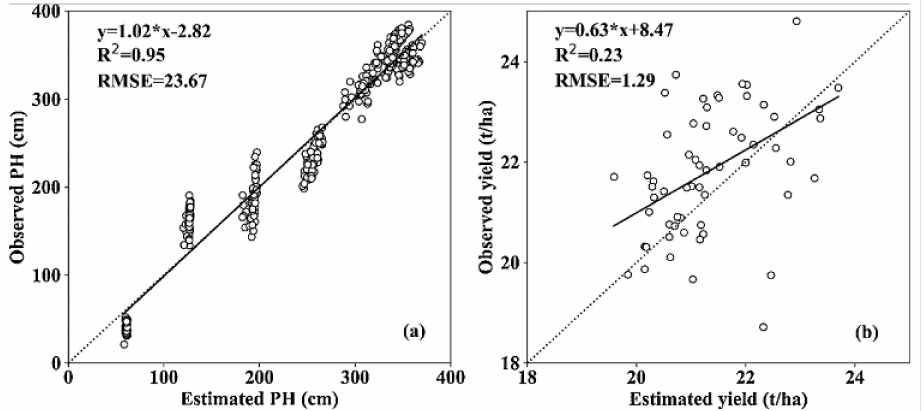
Figure 25. Sugarcane yield estimation model from Yu et al. [245]; plant height (PH) from LiDAR- derived data was compared to observed height (cm) ( a ); sugarcane yield (t/ha) prediction was performed from the model ( b